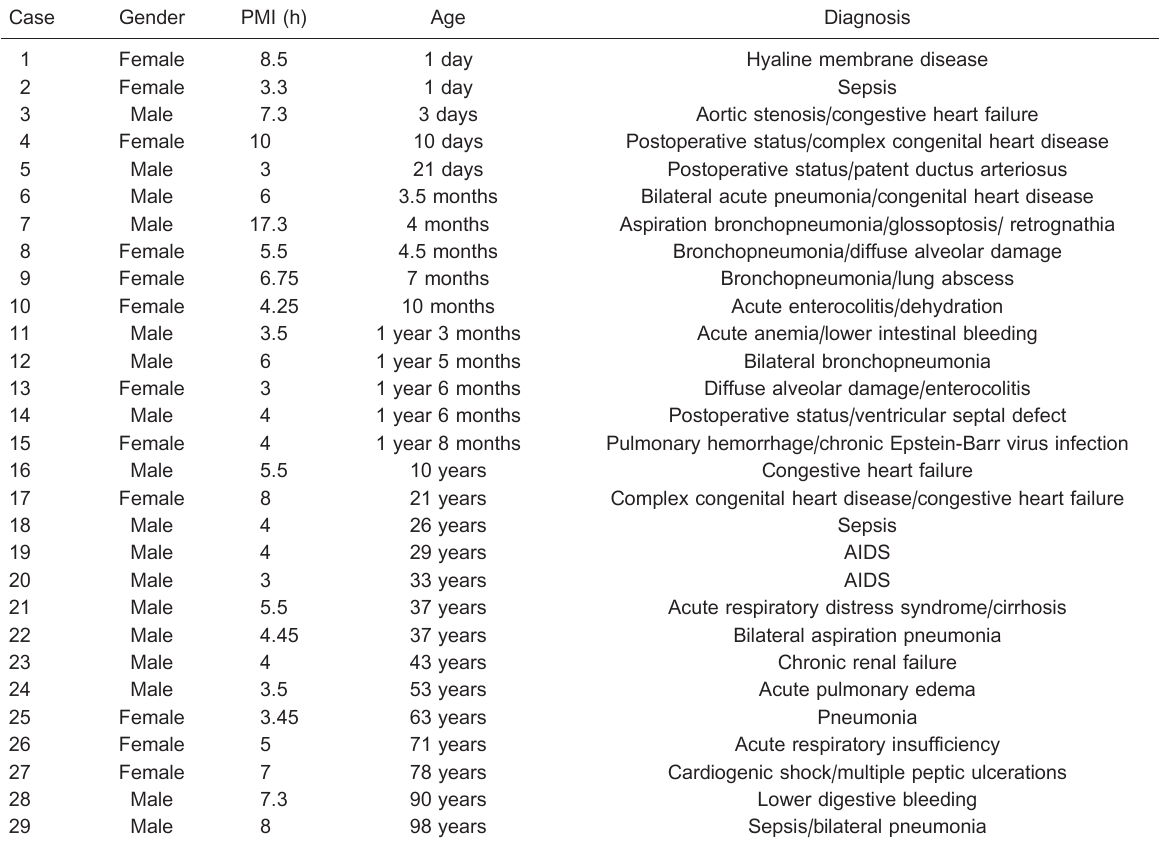
Table 1. Clinical data of 29 human necropsies whose cerebella were used to evaluate myosin Va